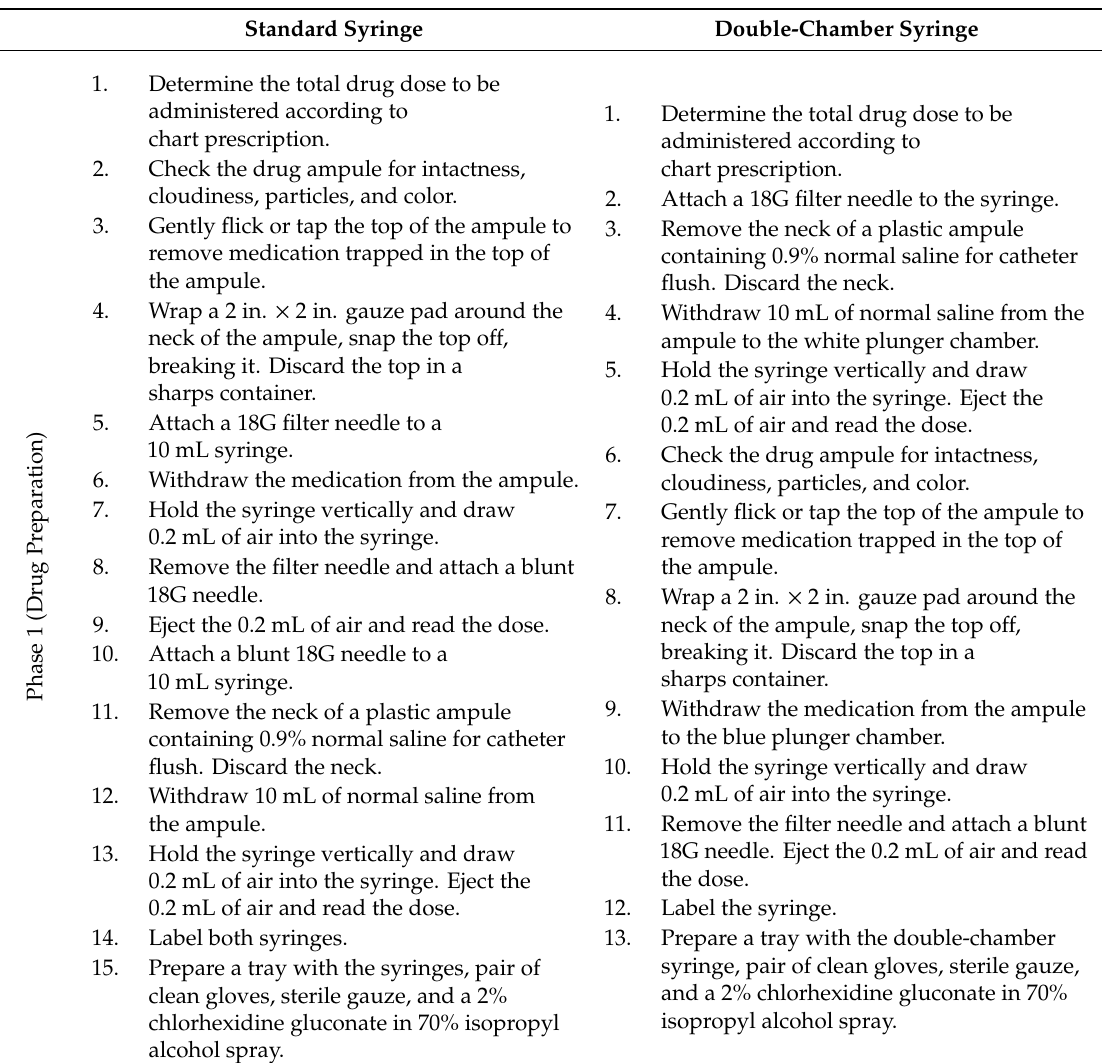
Table 3. Procedures to be accomplished by the study participants: drug preparation. Standard